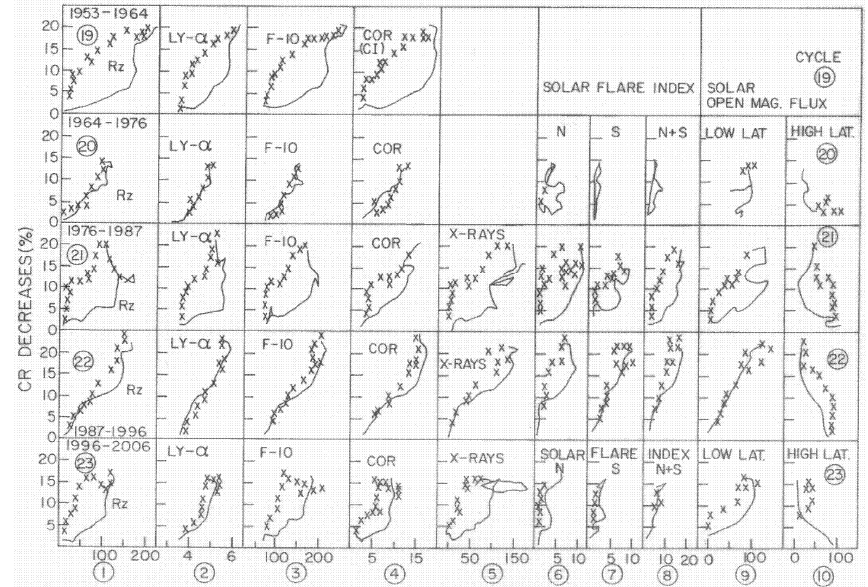
Fig. 2. Hysteresis plots of Cosmic Ray (CR) intensity (ordinate in percent, 3-monthly values) versus several solar parameters (abscissa), columns 1–10. The abscissa scale is arbitrary, adjusted to suite the available space. The full lines are for the rising part of the solar cycle and the crosses for the declining